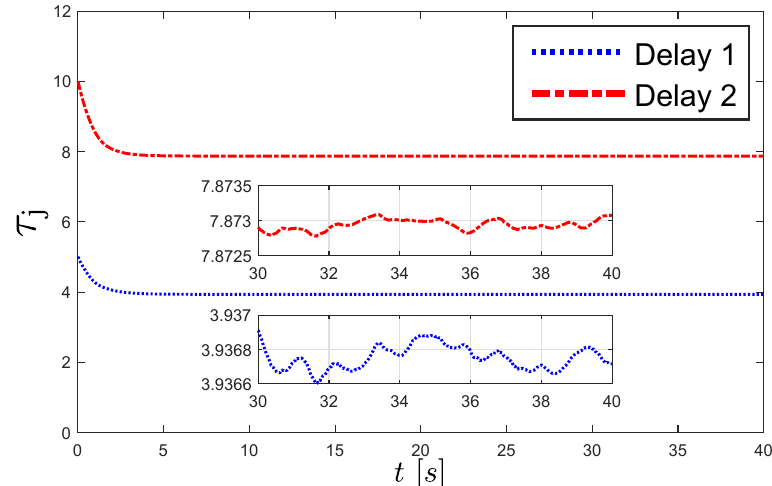
Figure 7. Time evolution of the delay for the first trajectory.